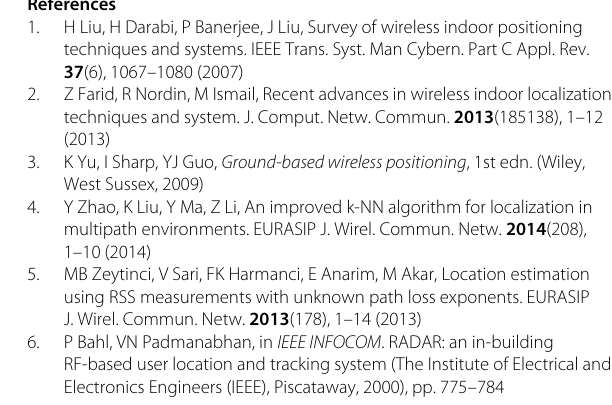
MD and the BS. For such a position, we may further note that everyone around the BS is most cumbersome.